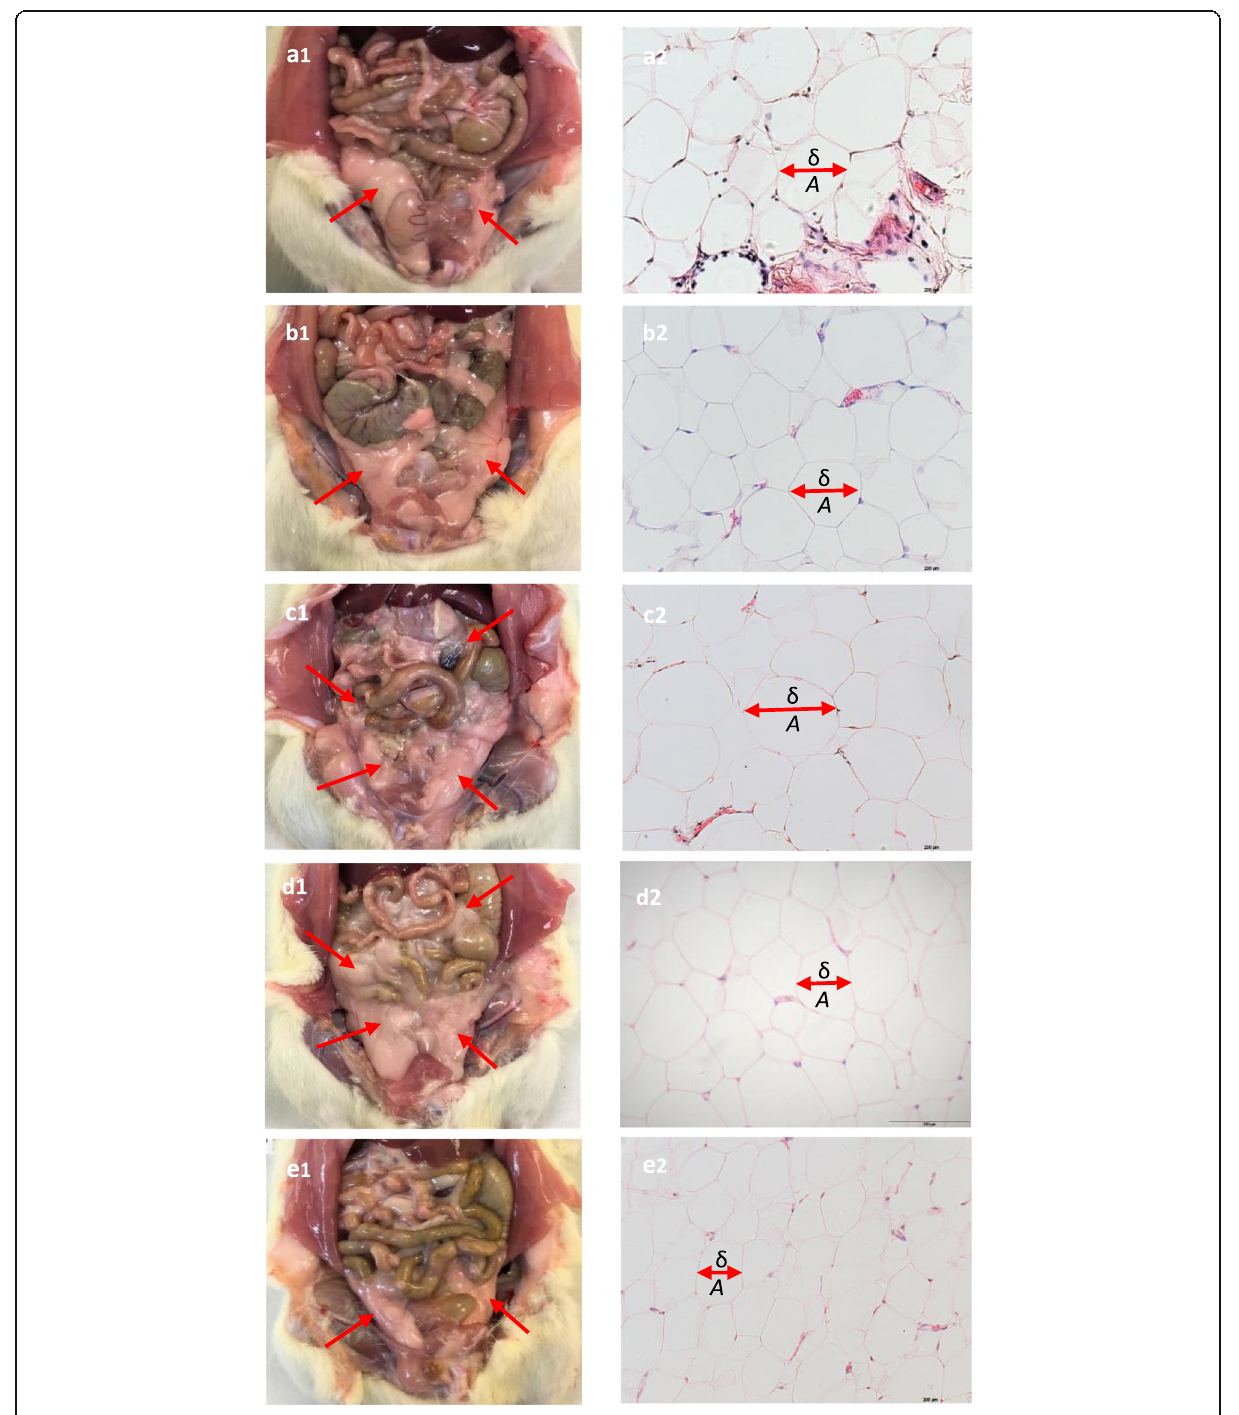
Fig. 1 The abdominal adipose tissue deposition ( a1 , b1 , c1 , d1 , e1 ) and the histomorphology ( a2 , b2 , c2 , d2 , e2 ) of adipocytes of C, PAE, MetS1, MetS2 and MetS3 respectively. The deposition of abdominal adipose tissue was greater in MetS1 ( c1 ) than C ( a1 ) and PAE ( b1 ) after 8 weeks of FDW consumption. The deposition of abdominal adipose tissue was lower in MetS3 ( e1 ) than MetS2 ( d1 ) with PA consumption. The histomorphology of adipocyte of MetS1 is different as compared to C and PAE where the size of adipocytes is increased in MetS1 as compared to C and PAE. The size of adipocyte which is indicated by diameter, perimeter, and area and the number of adipocytes was calculated. A : adipocyte, δ :